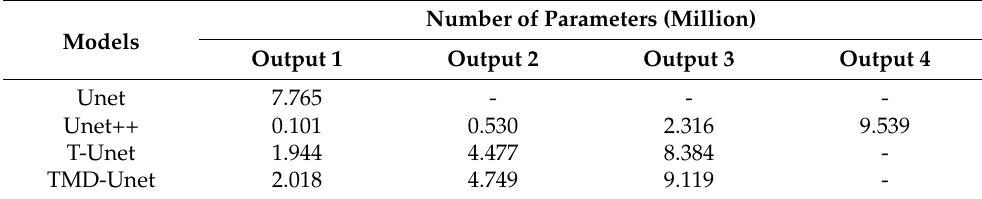
Table 6. Comparison of the parameter numbers on the sub-Unet